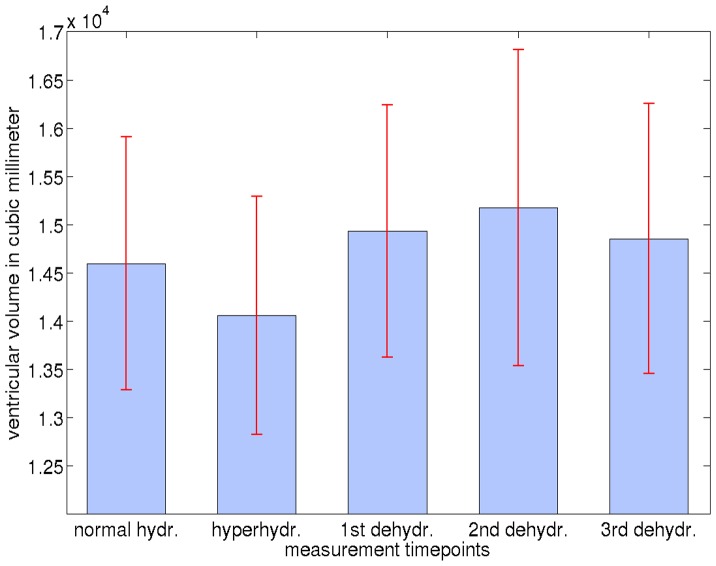
Volume of the ventricular system in mm3 (sum  =  lateral +3rd +4th ventricle) obtained with FreeSurfer for each hydration state.Red lines indicate standard error.